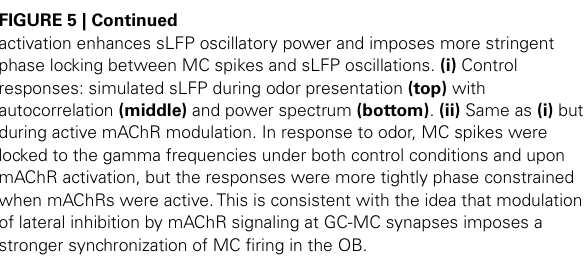
FIGURE 5 | Continued activation enhances sLFP oscillatory power and imposes more stringent phase locking between MC spikes and sLFP oscillations. (i) Control responses: simulated sLFP during odor presentation (top) with autocorrelation (middle) and power spectrum (bottom) . (ii) Same as (i) but during active mAChR modulation. In response to odor, MC spikes were locked to the gamma frequencies under both control conditions and upon mAChR activation, but the responses were more tightly phase constrained when mAChRs were active.This is consistent with the idea that modulation of lateral inhibition by mAChR signaling at GC-MC synapses imposes a stronger synchronization of MC firing in the